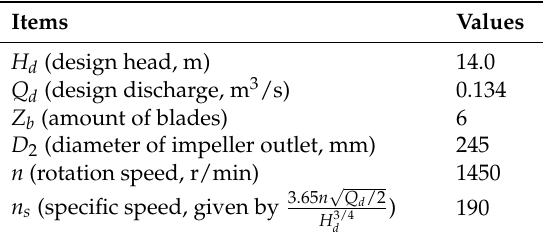
Table 1. The key parameters of the test